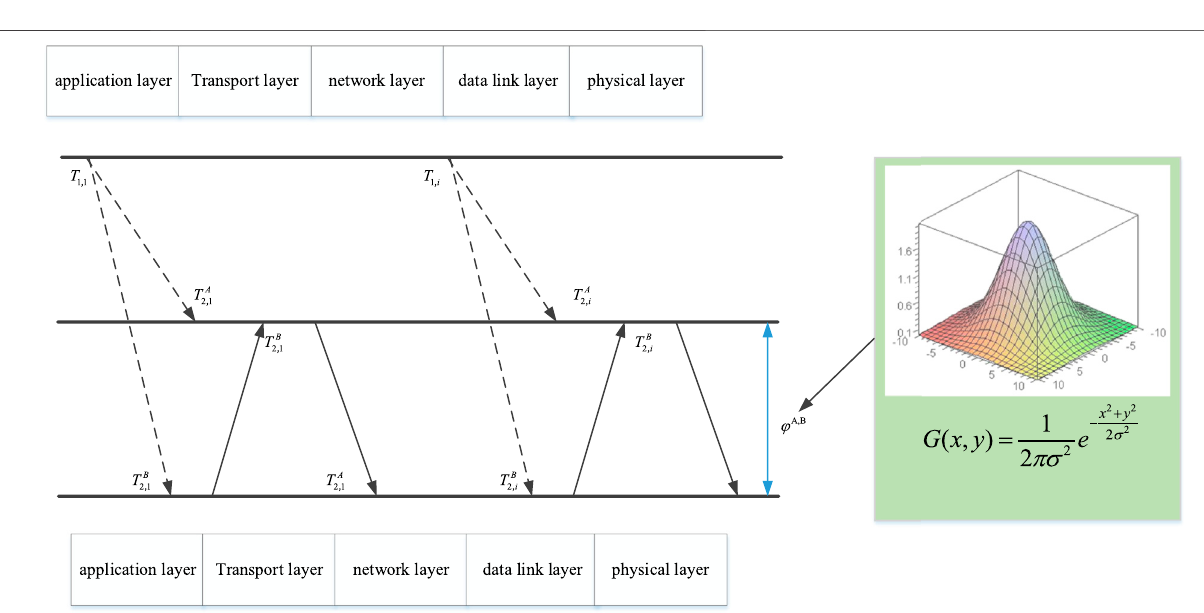
Frontiers in Bioengineering and Biotechnology |